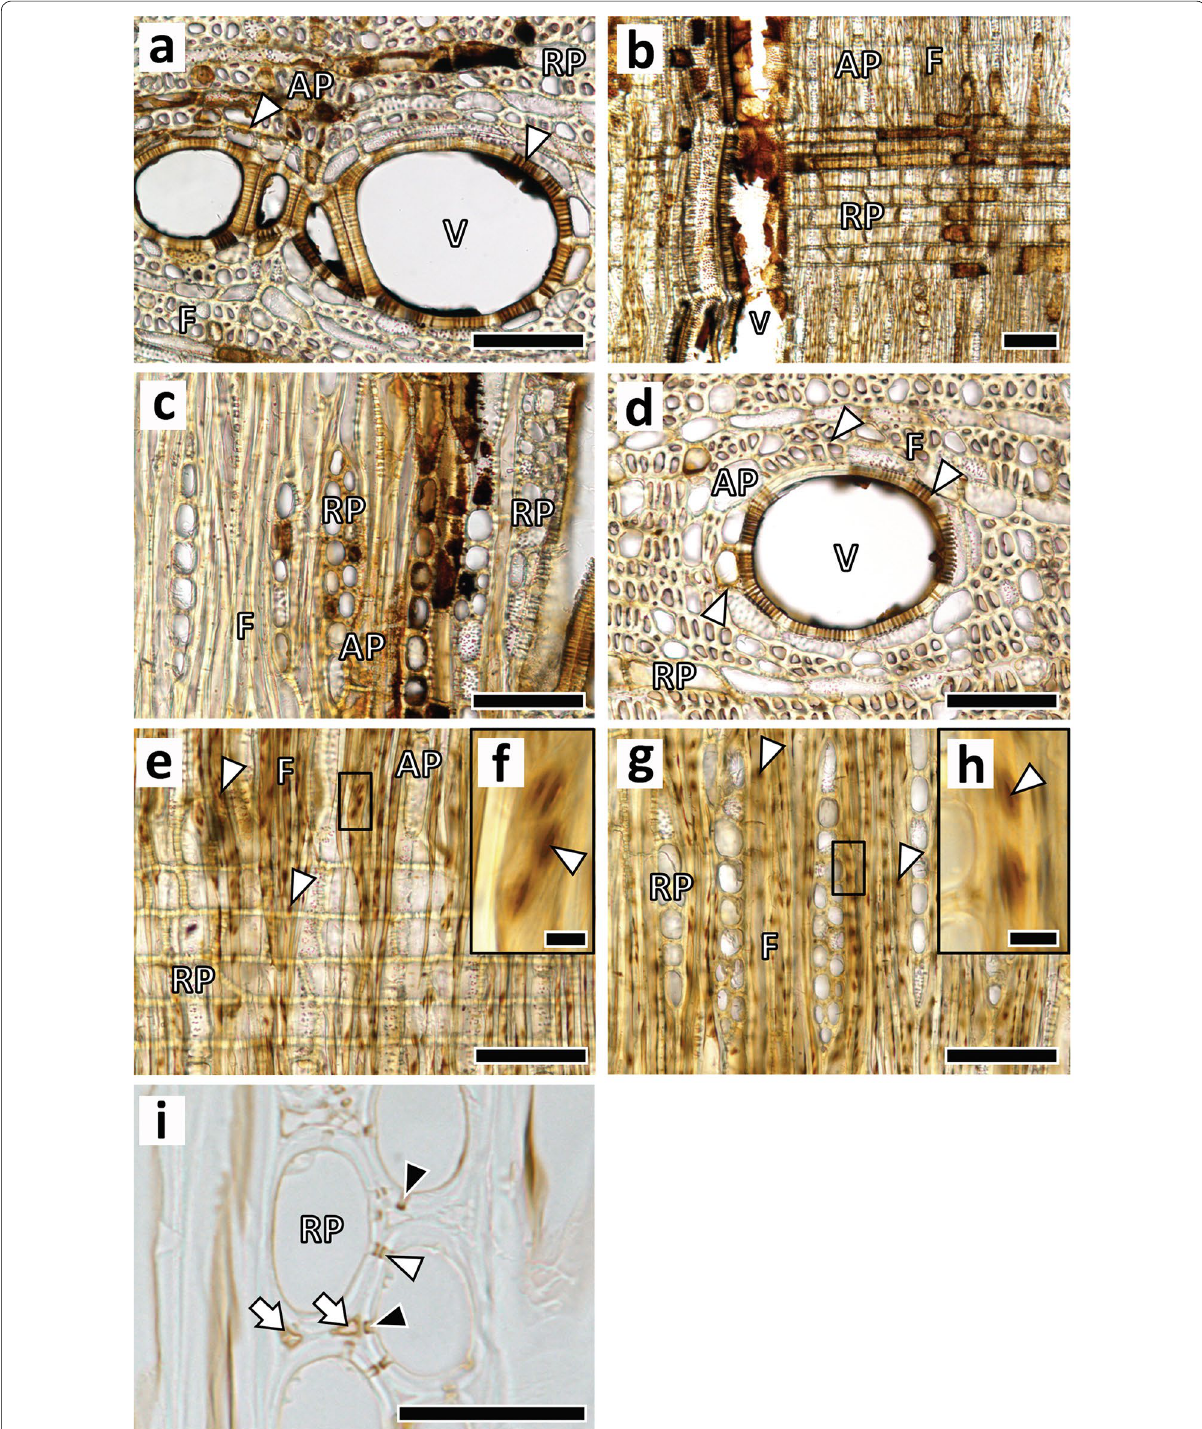
Fig. 3 Light micrographs of transverse ( a , d ), radial ( b , e , f ) and tangential ( c , g , h , i ) sections of gray regions of samples of D . kaki wood. f , h Higher-magnification views of the enclosed areas in e , g , respectively. White arrowheads indicate colored substances in pits. White arrows indicate colored substances on interior surfaces of intercellular spaces within rays. AP: axial parenchyma cell; F: wood fiber; RP: ray parenchyma cell; V: vessel element. Scale bars 100 μm in a – d , e , g ; 5 μm in f , h ; 25 μm in =